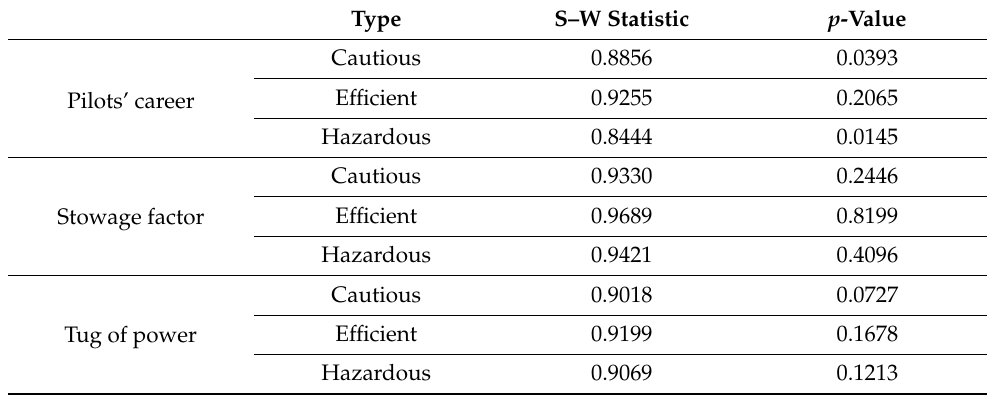
Table 8. Normality test of